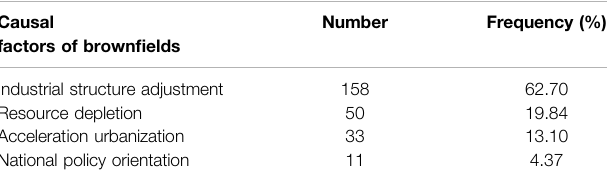
TABLE 2 | Frequency of formation factors of brown fi eld occurrence records in